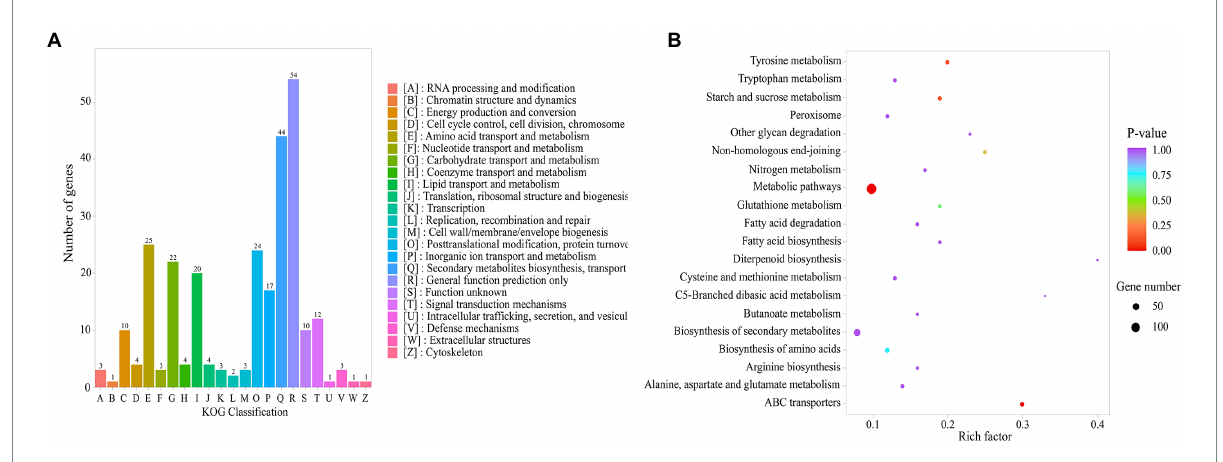
FIGURE 3 (A) A cluster of orthologous groups annotations of assembled DEGs. (B) KEGG enrichment of DEGs. Rich ratio = term candidate genes num/term genes num. P- value ≤ 0.05 indicates significant enrichment.